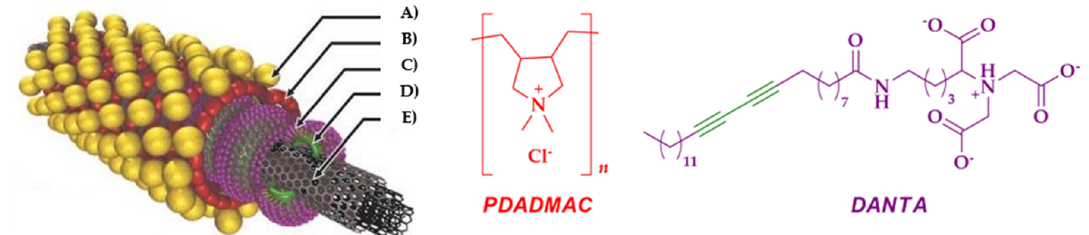
Figure 2. Au carbon nanotube (CNT) nanohybrid ( A ) AuNP; ( B ) poly(diallyldimethylammonium chloride) (PDADMAC) layer; ( C ) diacetylene nitrilotriacetic amphiphile (DANTA) nanorings; ( D ) polymerized region (green); ( E ) multiwalled CNT. Adapted from [69].